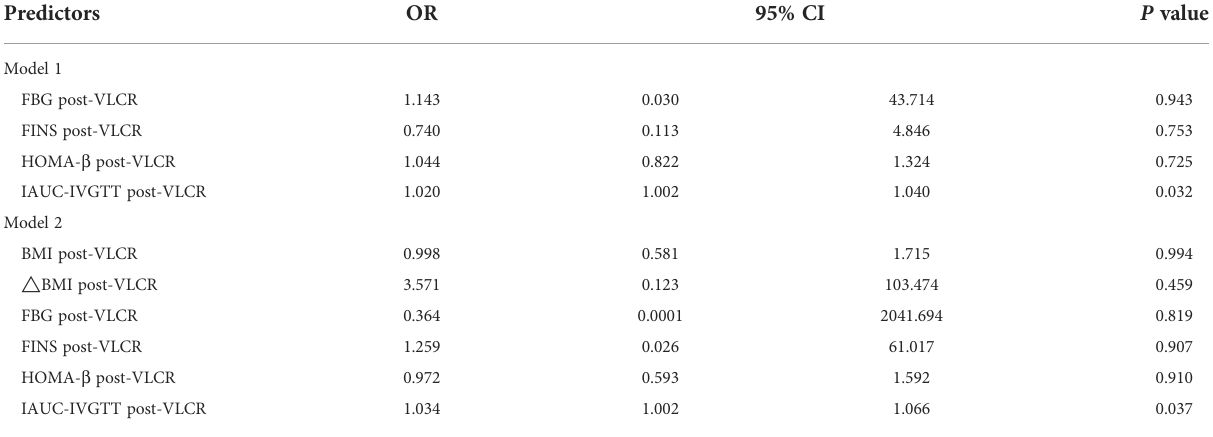
TABLE 10 Multivariable logistic regression analysis for predictors of diabetes remission.